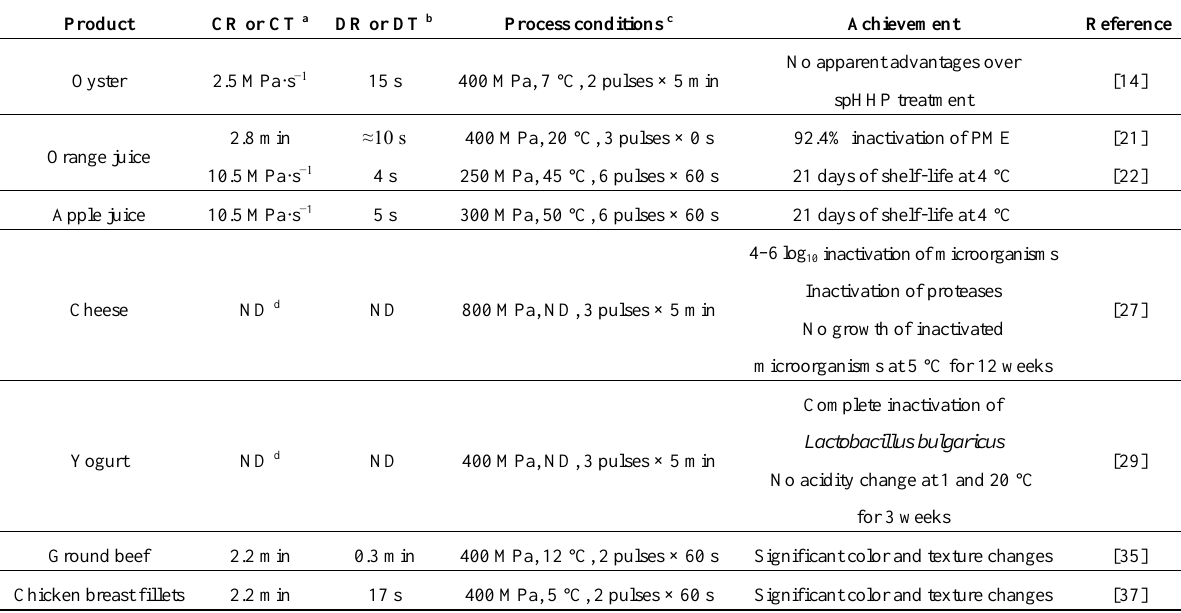
Table 2. Summary of studies on the effect of mpHHP treatment on quality, shelf-life, microbial and enzyme inactivation of